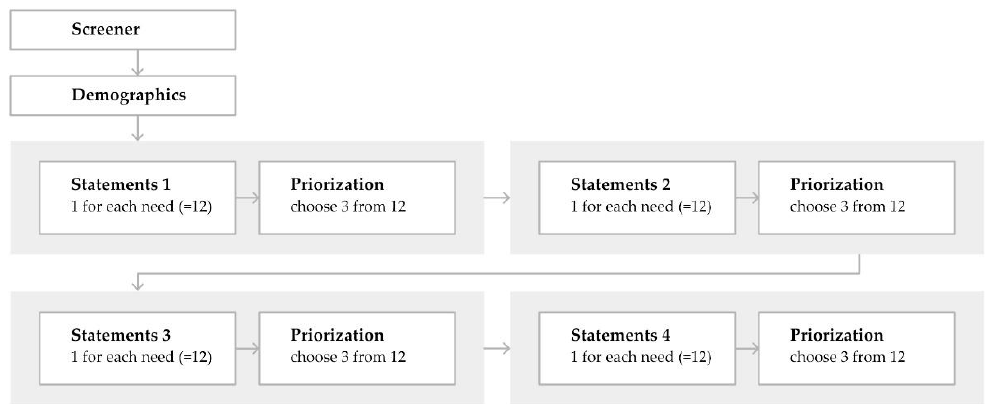
Figure 3. Overview of the different phases of the online survey.